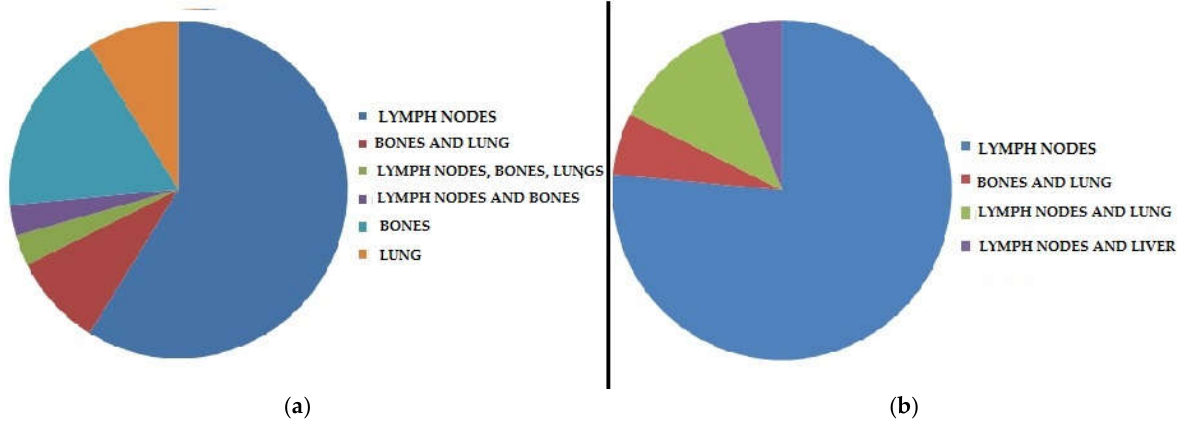
Figure 2. Graphic distribution of lesions detected by PET/CT in the 2 groups of patients: ( a ) patients (n = 40) examined in clinical setting 1; ( b ) patients (n = 26) evaluated in clinical setting 2. Table 3. Additional sites of disease detected by 18 F-FDG PET/CT in patients with morphological findings suspected of relapse.